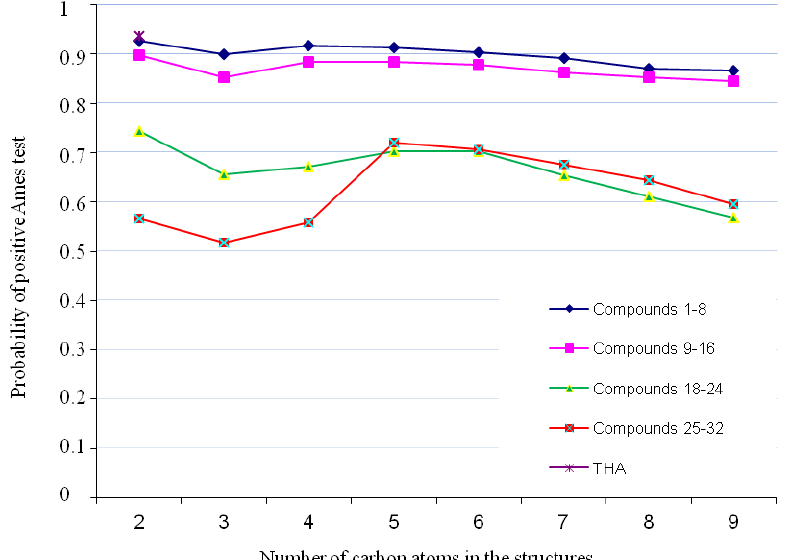
Figure 2. Genotoxicity profile for analyzed